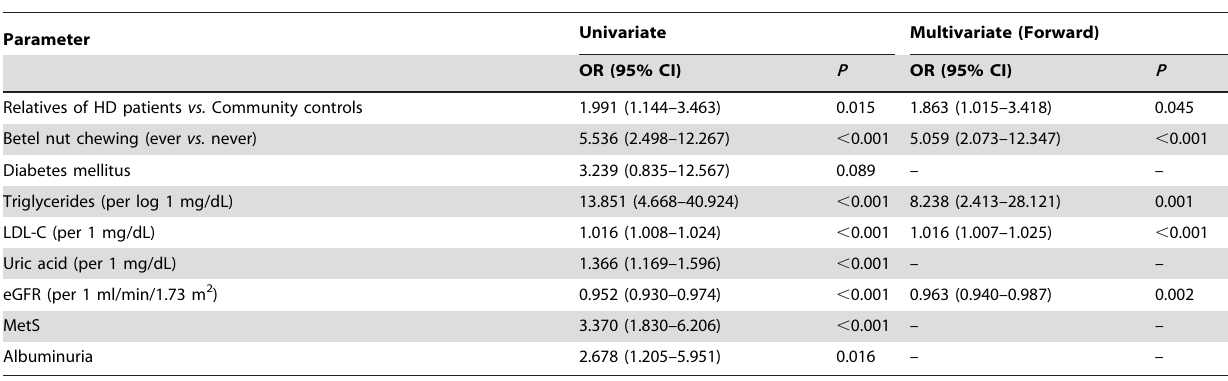
Table 4. Determinants of high FRS risk in all subjects.